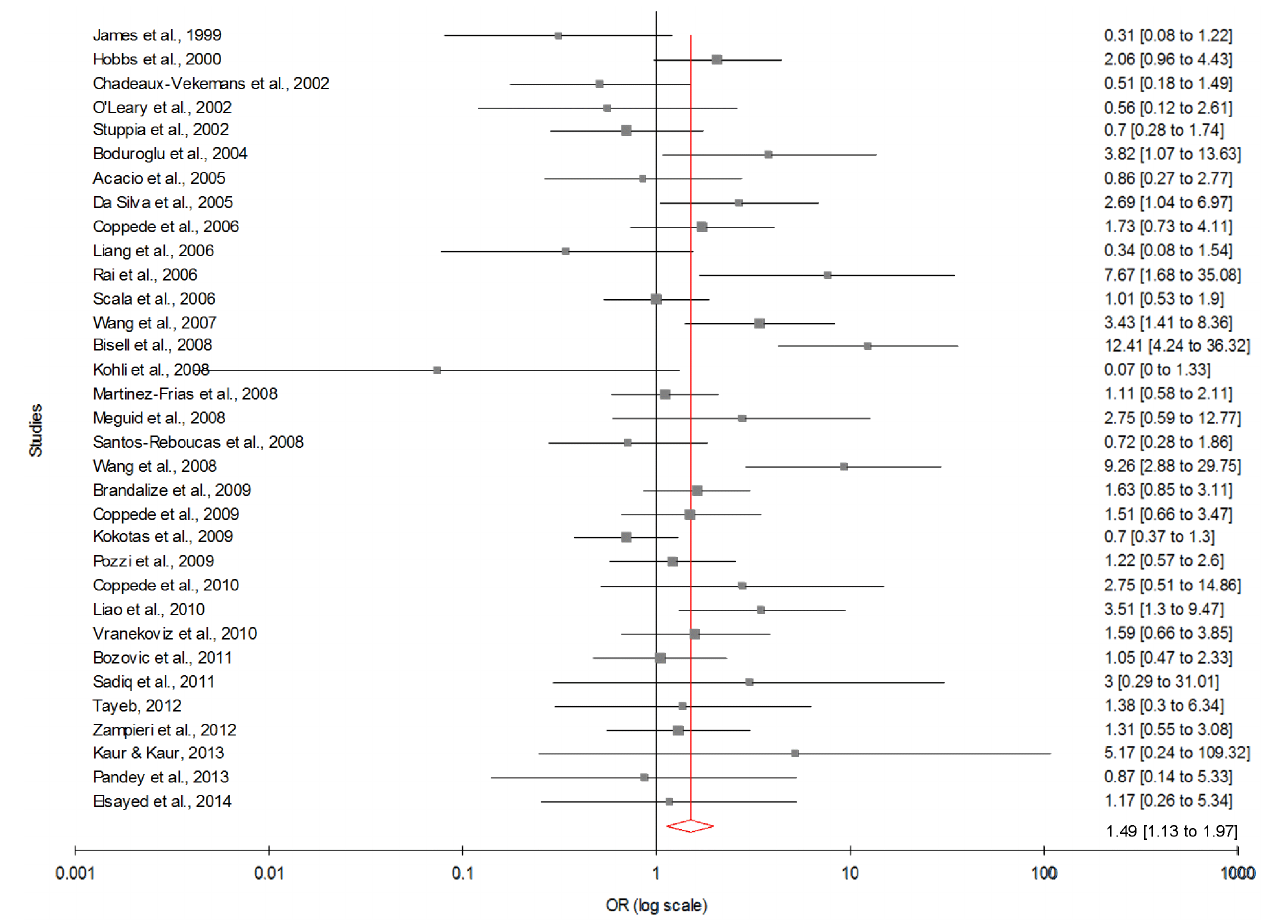
Figure 3. Forest plots (Random effect) showed significant association between MTHFR C677T polymorphism and risk of Down syndrome. Results of individual and summary OR estimates and 95% CI of each study were shown using homozygote model (TT versus CC).